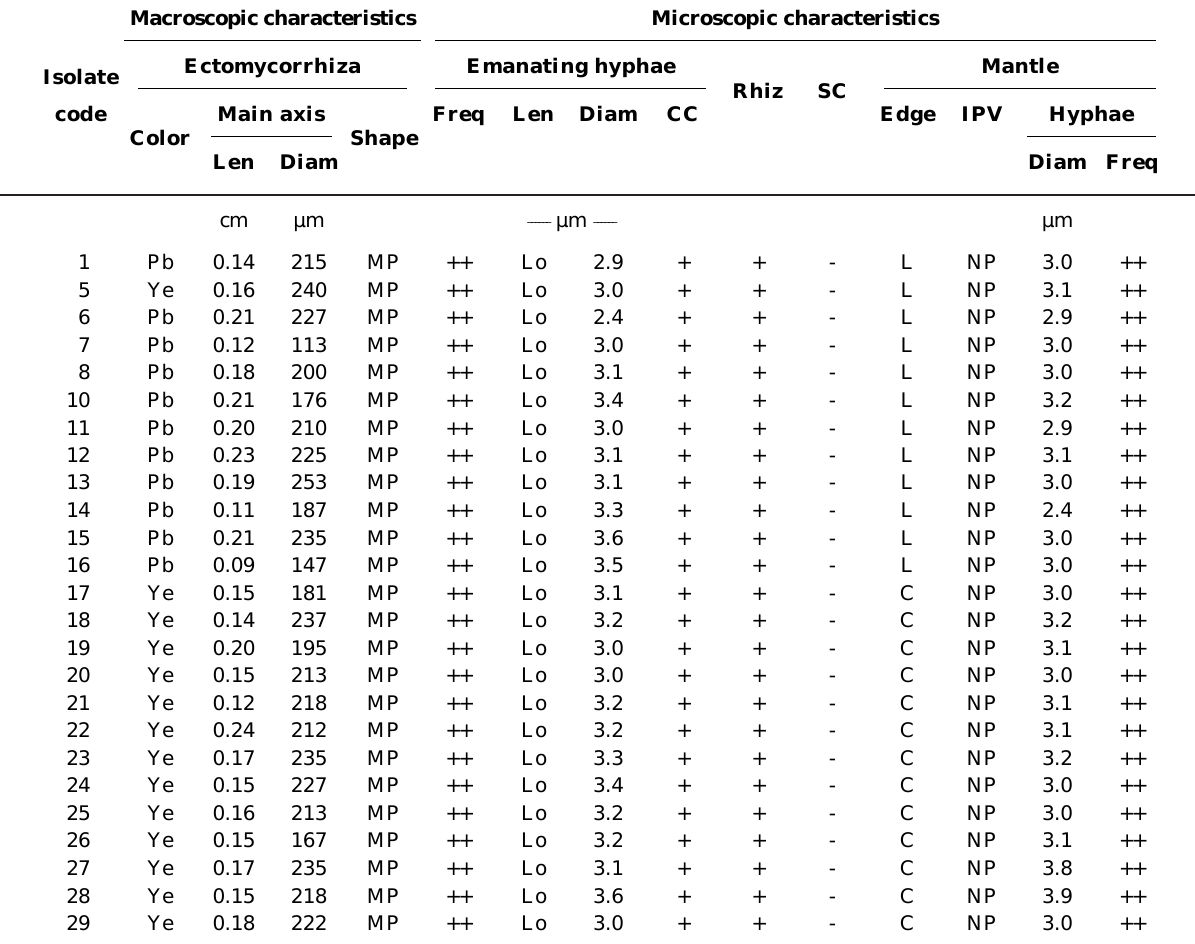
Table 3. Macroscopic and microscopic characteristics of ectomycorrhizae formed on Eucalyptus urophylla by Pisolithus sp. isolates, 110d after cultivation under greenhouse conditions Macroscopic